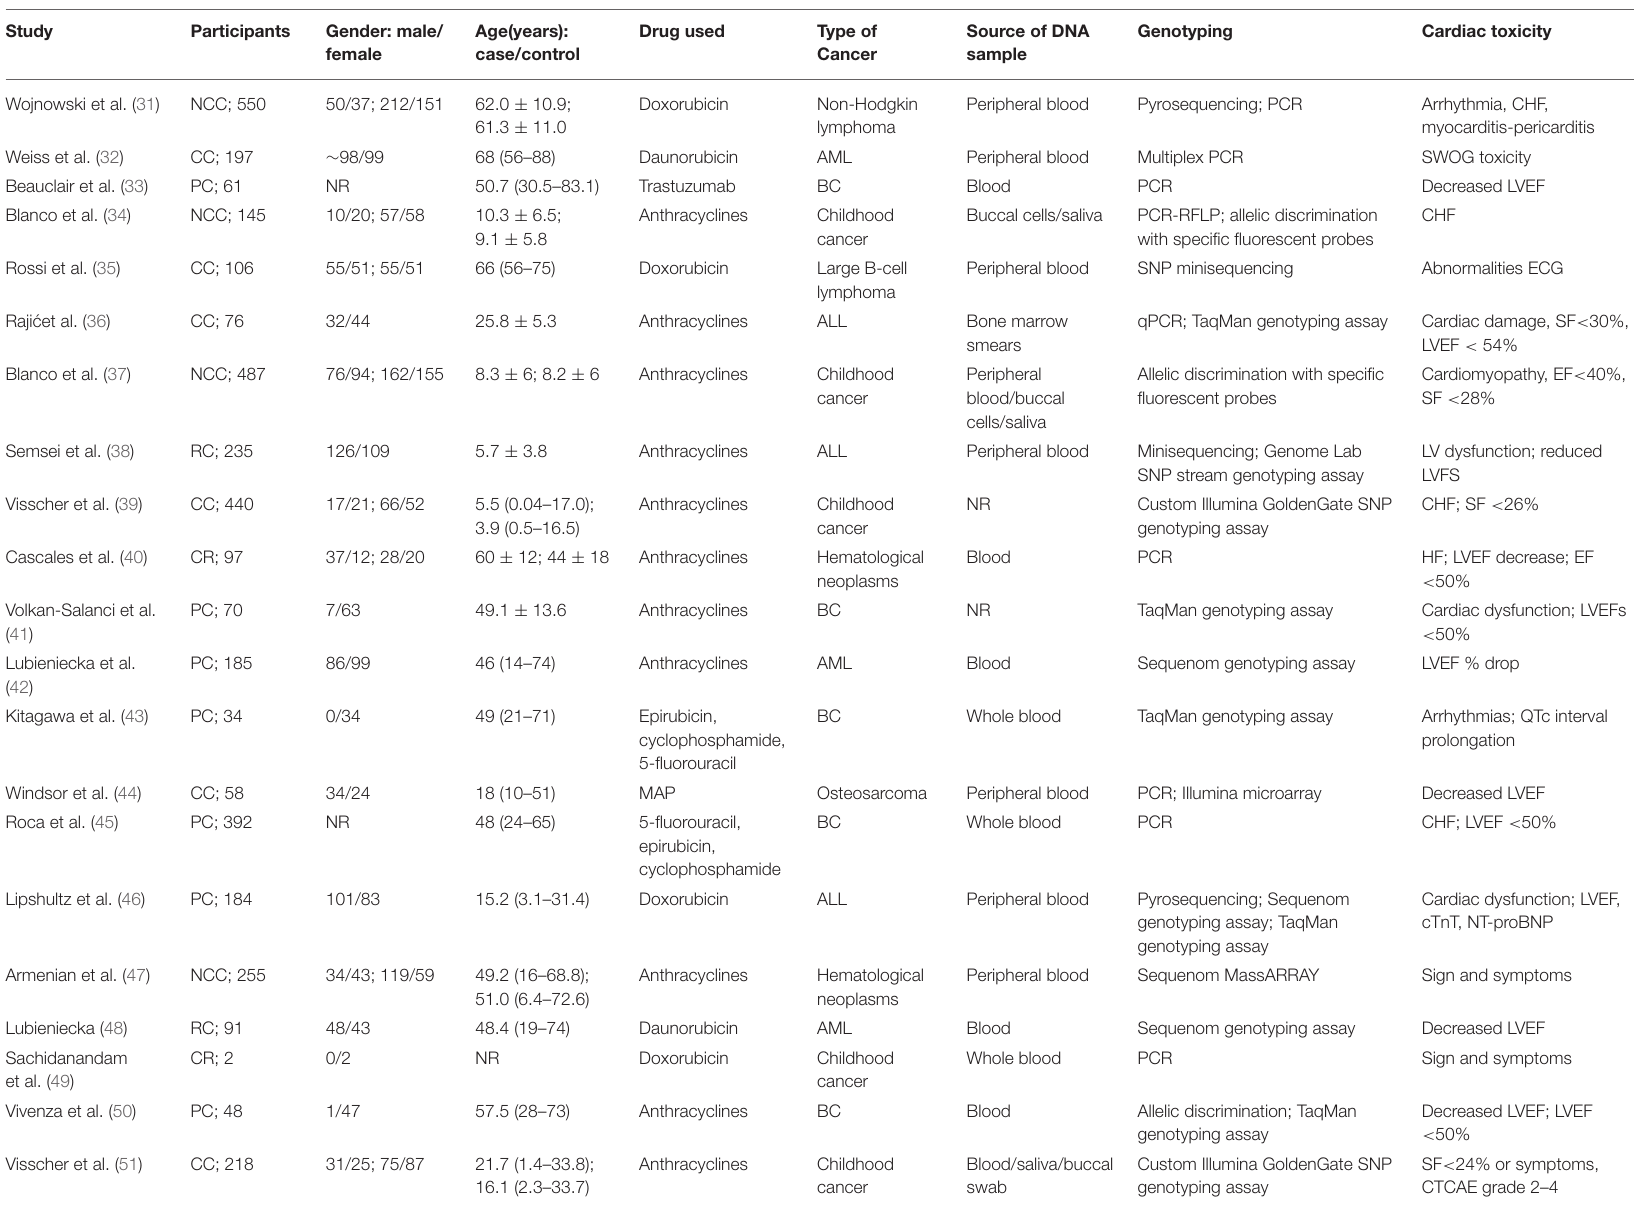
TABLE 1 | Genetic polymorphisms in chemotherapy-induced cardiotoxicity